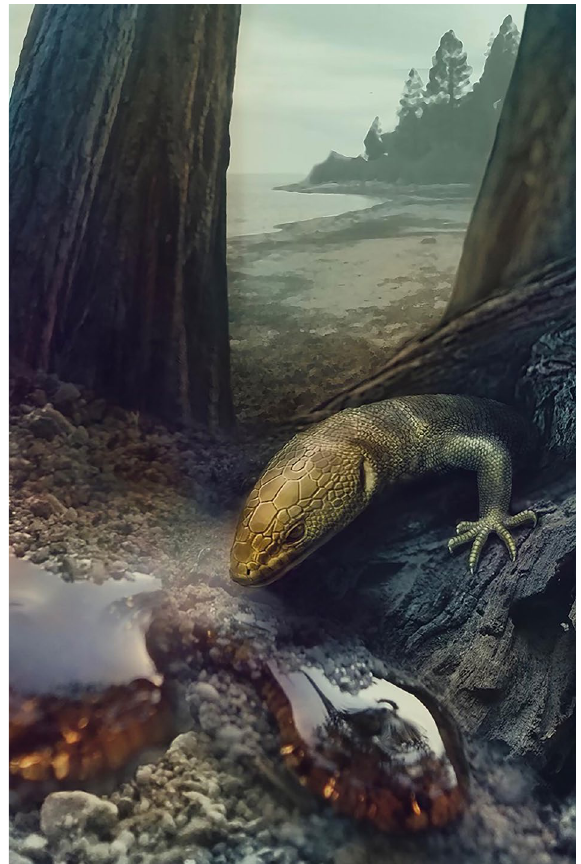
Figure 5. Retinosaurus hkamtiensis prior to being trapped in tree resin 110 mya (Scientific illustration by Stephanie